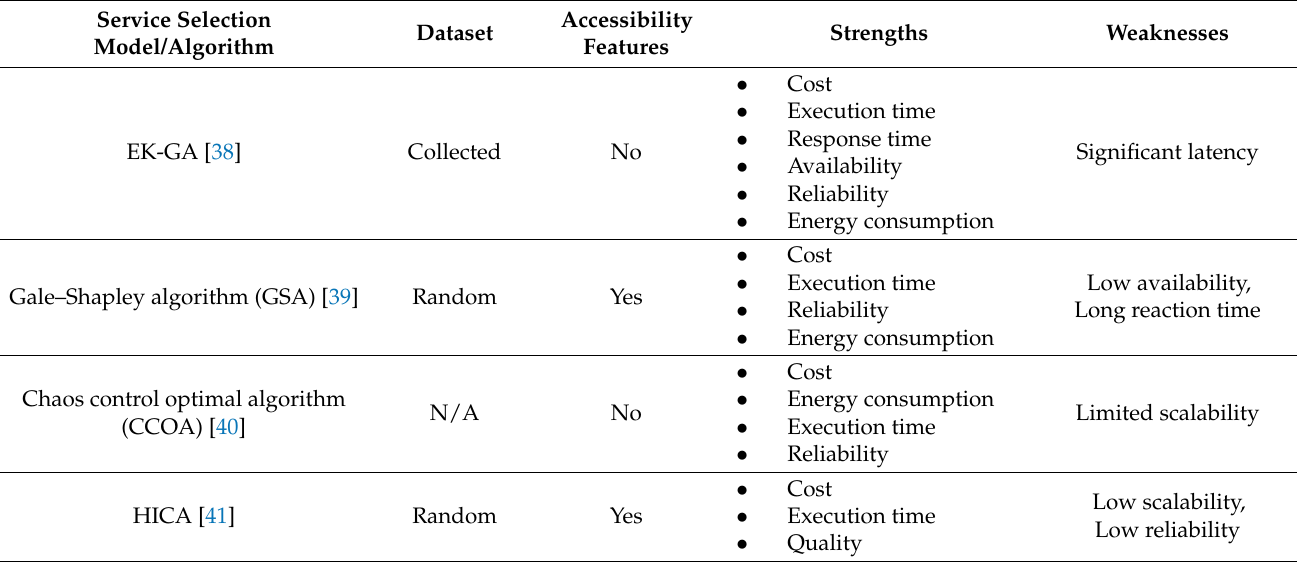
Table 1. Summary of prominent service selection models and their